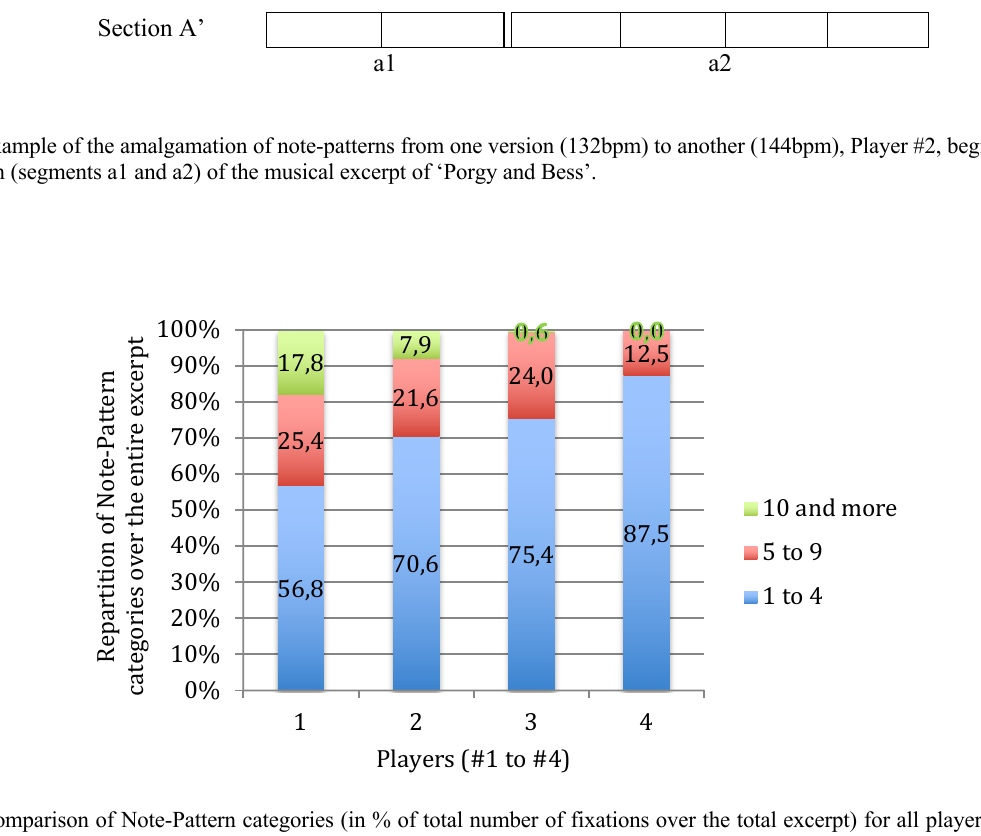
Figure 14. Comparison of Note-Pattern categories (in % of total number of fixations over the total excerpt) for all players across all tempos for the musical excerpt of ‘Porgy and Bess’. Players are numbered 1 to 4 (x-axis), and Note-Patterns are grouped in 3 categories: 1 to 4 notes, 5 to 9, 10 and